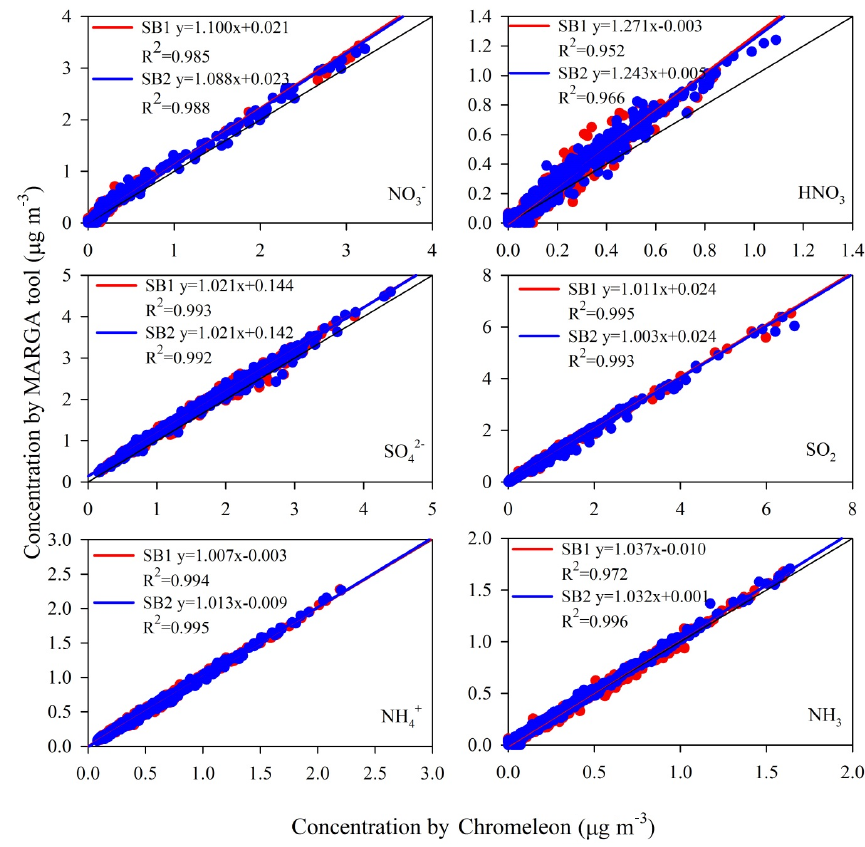
Figure 1. Comparison of concentrations of analytes monitored during fall of 2014 at Duke Forest as reported by MARGA tool and Chromeleon. Data points with misintegration issues by MARGA tool were excluded from this comparison. Data for individual sample boxes (SB1 and SB2) are